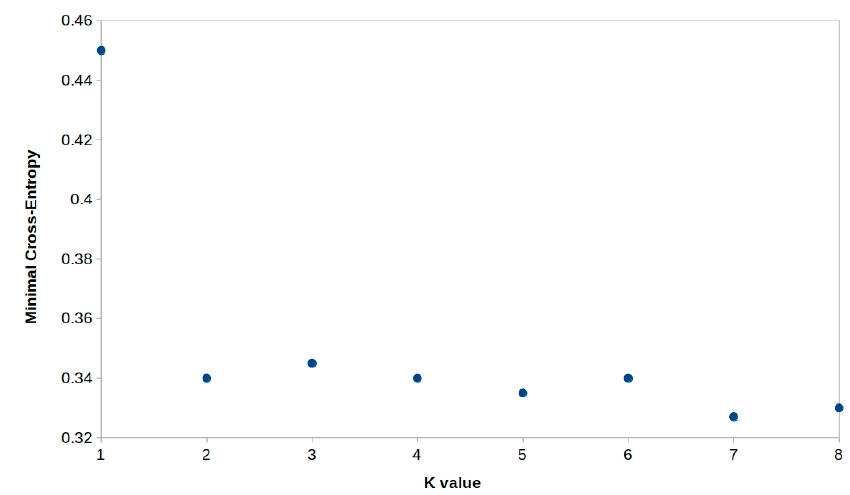
Figure 1. Sampling locations in the Aegean Sea and structure pies with locprior K = 2 (different colors represent the two different genetic clusters). Numbers indicate the sampled area of individuals. 1: Thasos (THA)—30 specimens; 2: Kavala (KAV)—24 specimens; 3: Chalkidiki (CHA)—28 specimens;